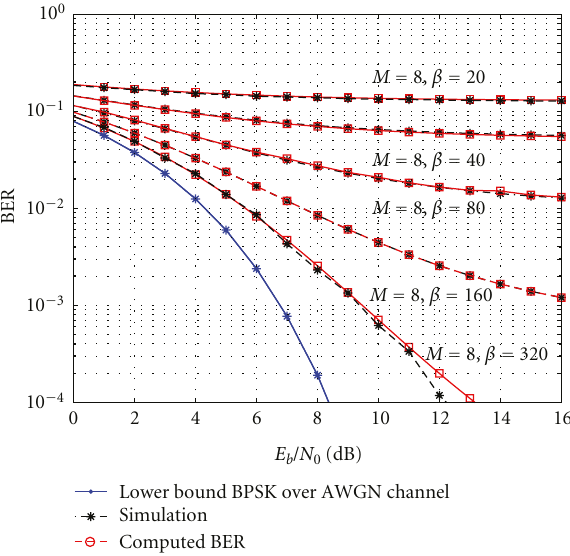
Figure 4: Numerical computation and simulated BER for M = 8 and β = 20,40,80,160,320.